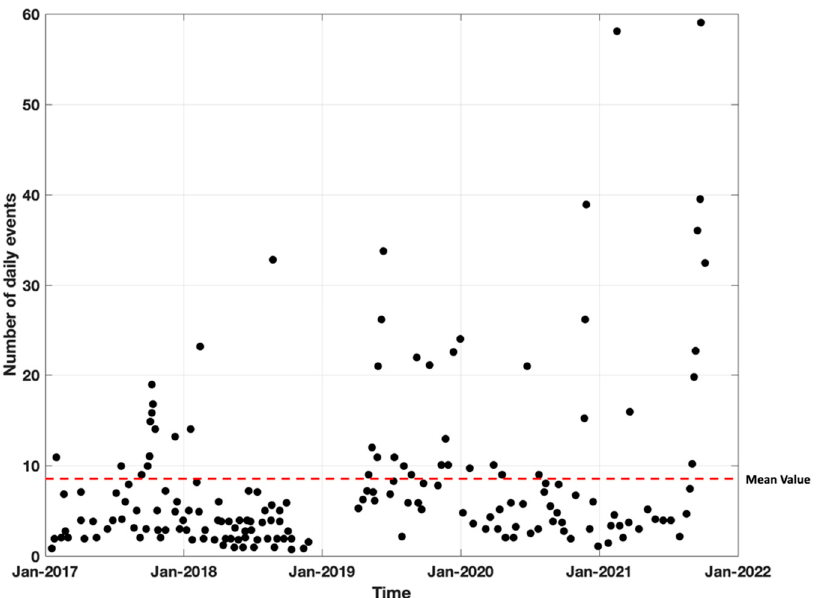
4 of 15 Figure 2. Zoomed 3D view of La Fossa cone. The main fumarolic field on the northern rim is highlighted. Before this current one, there were already periods of increased intensity in degassing activities, particularly in 1978–1980, 1988–1991, 1996, 2004–2007, and 2009–2010 [25]. These crises were related to an unrest phase, defined as variation from the standard activity [26] and were usually recognized by monitoring geophysical and geochemical